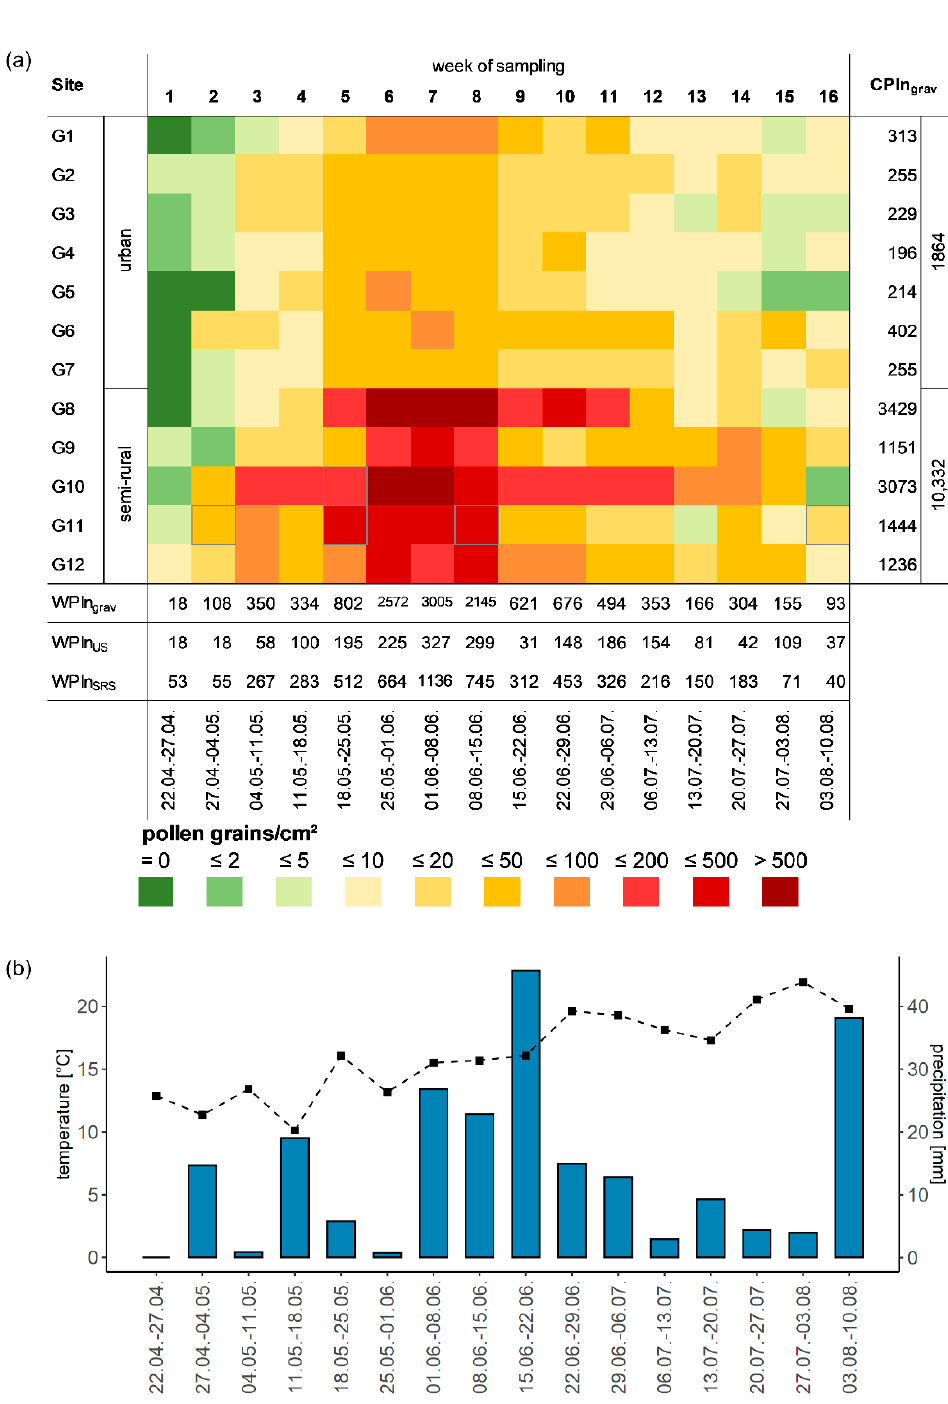
Figure 5. ( a ) Heatmap showing weekly grass pollen deposition (pollen grains/cm 2 ) in 2020 for the sampling campaign from 22 April to 10 August 2020, WPIn grav , WPIn US , and WPIn SRS for the respective weeks. Gravimetric traps are ordered by distance from the urban station (US). A grey outline indicates interpolated values; ( b ) weekly mean temperature (black squares/dotted line) and weekly sum of precipitation (blue bars) during the sampling campaign with gravimetric traps